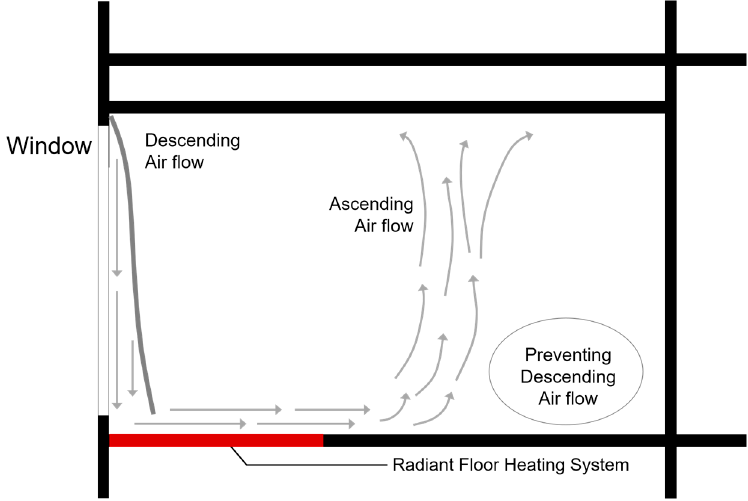
Figure 2. Airflow by application of RFHS (wide area/relatively low surface temperature).